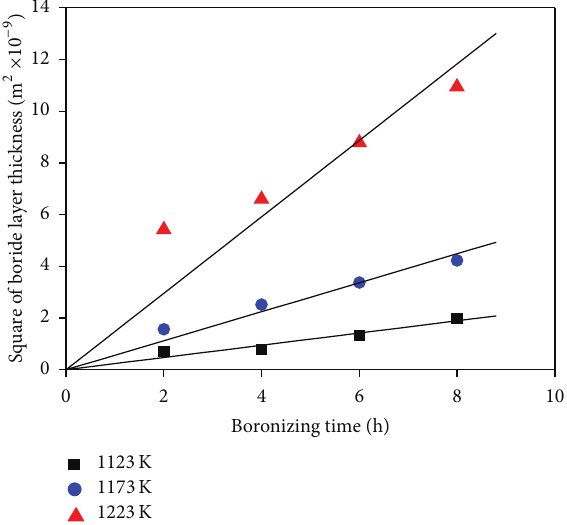
Figure 5: Square of boride layer thickness of boronized GCI as a function process